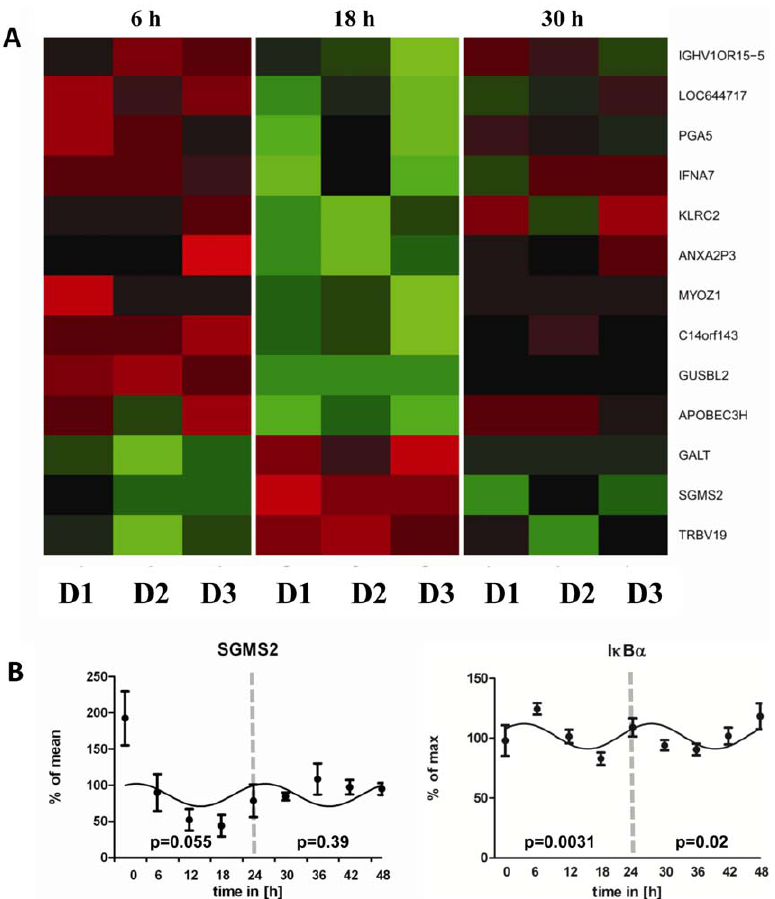
Figure 6. Circadian microarray and qPCR analysis of stimulated CD4 + T cells in vitro. Blood was sampled from three healthy young males at 10 AM. CD4 + T cells were isolated from whole blood by MACS technology. Aliquots of purified CD4 + T cells (mean purity: 90.94% 6 0.46%) were cultured up to 48 h. For microarray analysis aliquots were taken out in 6 h intervals and stimulated. Cells were stimulated 3 h with PMA/ionomycin. At the first and second peak as well as at the first trough of IFN- c production cells were harvested for microarray analysis to identify candidate genes involved in the circadian regulation of IFN- c production. A) Heat map of candidate genes identified by ANOVA. B) qPCR was performed from all time points (9 time points over 48 h) for SGMS2 and I k B a . The p-values depicted in each graph were calculated by Cosinor analysis (Table. S2). The x-axis reflects the time cells were in culture. The dashed line splits the first and second 24 h period. P-values were separately calculated for the first and second 24 h and are depicted